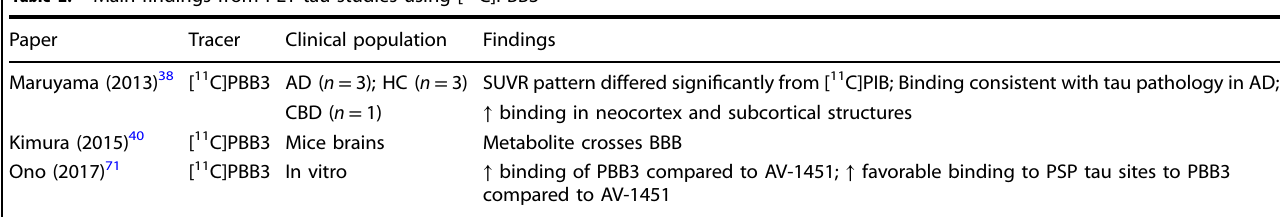
Table 2. Main fi ndings from PET tau studies using [ 11 C]PBB3 Paper Tracer Clinical population